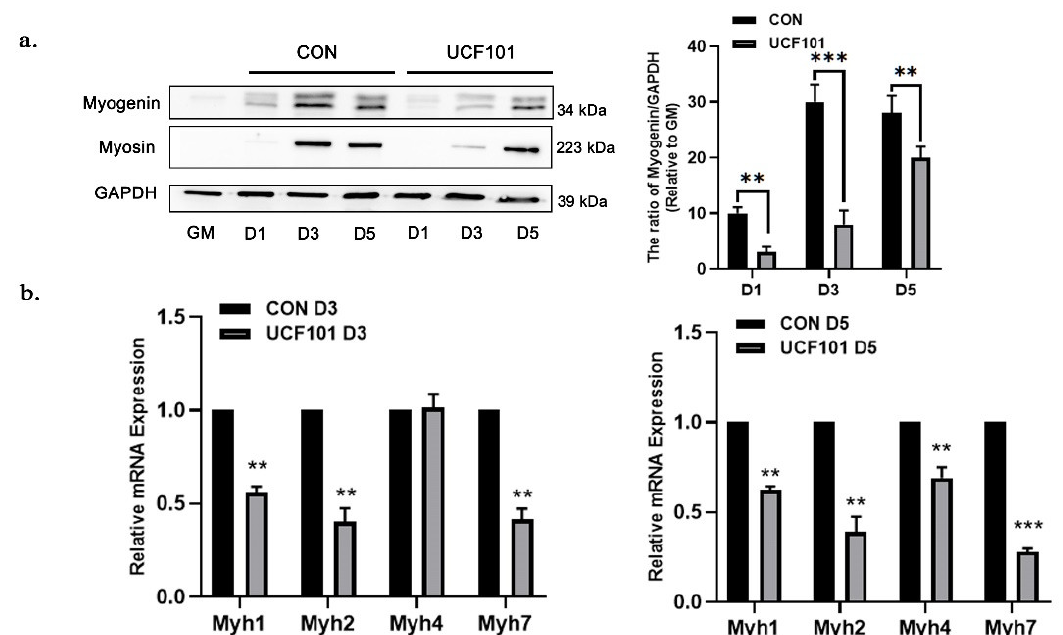
Figure 3. HtrA2/Omi protease deficiency reduced transcription and expression of differentiation marker proteins in C2C12 myoblasts. ( a ) Western blot of muscle differentiation marker proteins Myosin and Myogenin at differentiation on D1, D3, and D5 in C2C12 myoblasts treated and untreated with UCF101 (20 μM) and quantification of Western blots relative to GM ( n = 3). ( b ) qPCR was performed to detect the transcript levels of Myh1, 2, 4, and 7 at differentiation on D1, D3, and D5 in C2C12 myoblasts treated and untreated with UCF101 (20 µ M). Two-tailed unpaired Student’s t tests were used. Statistical significance: ** p ≤ 0.01, *** p ≤ 0.001.